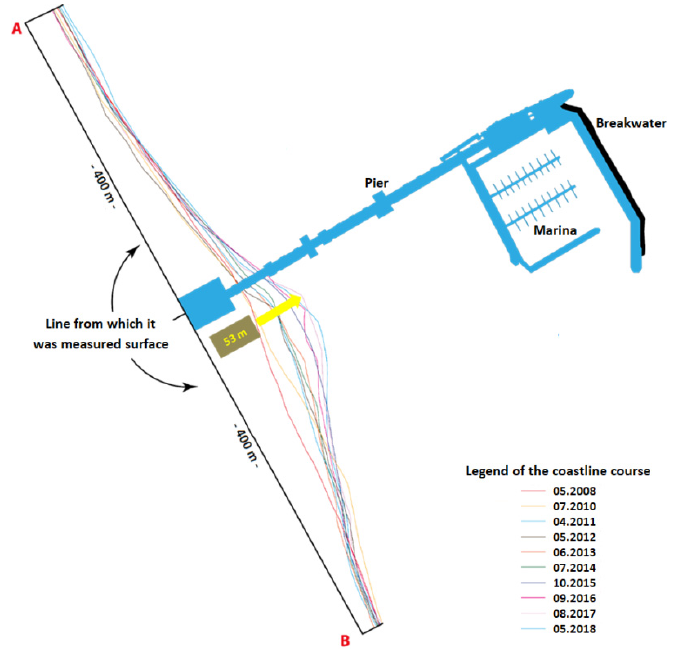
Figure 17. The course of the Sopot beach coastline over the years 2008-2018.